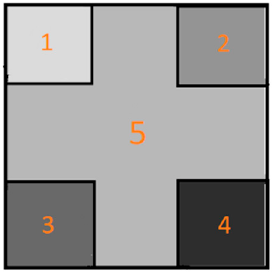
Figure 2. A sample image from training dataset used in training CNN for distinguishing air pollutant. Grey scales of numbered zones are determined by a sample’s five parameters.